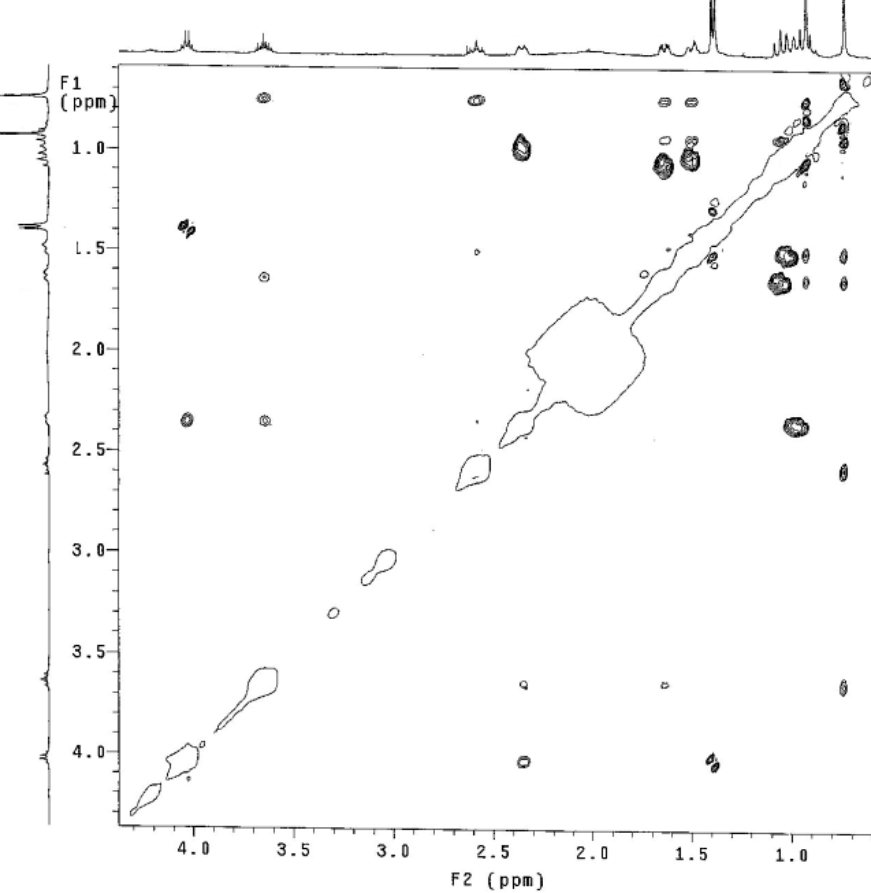
Figure 6. NOESY experiment for compound trans - 4 (CDCl